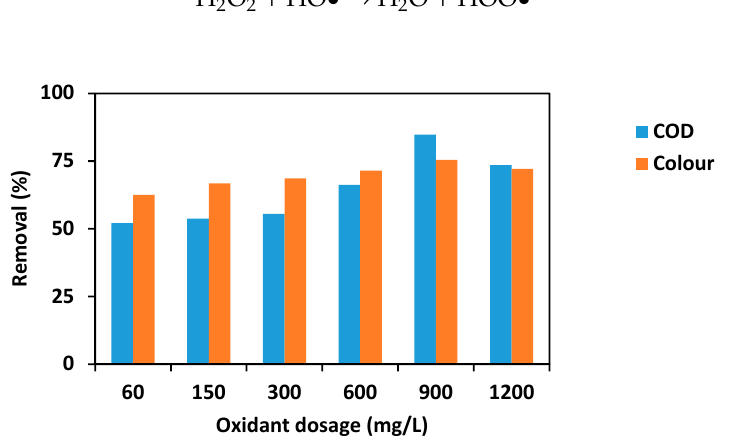
Figure 6. Effect of oxidant dose on photocatalytic degradation (process conditions: pH—4, reaction time—3 h, UV light irradiation—64 W, catalyst dose—500 mg/L).